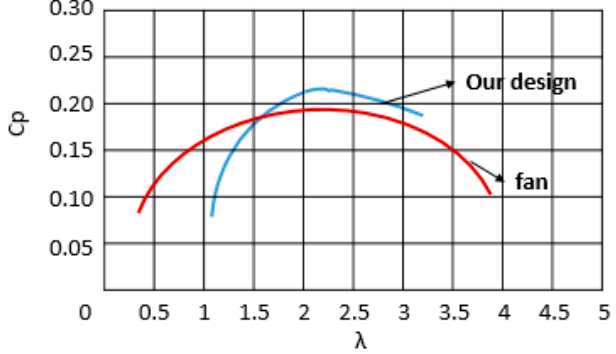
Figure 13. Comparison of the fan energy utilization coefficient curve with the same number of blades.